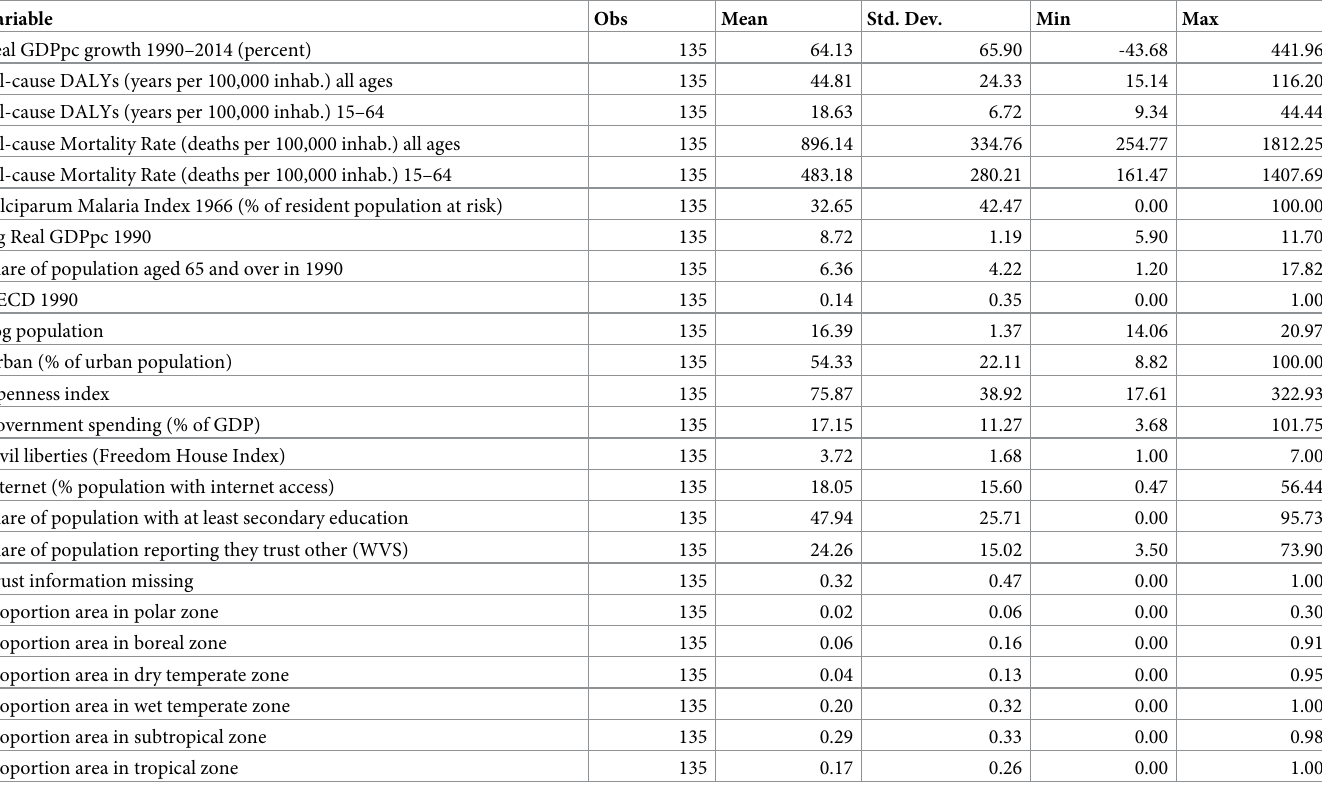
Table 1. Summary statistics. Variables Averaged over the period